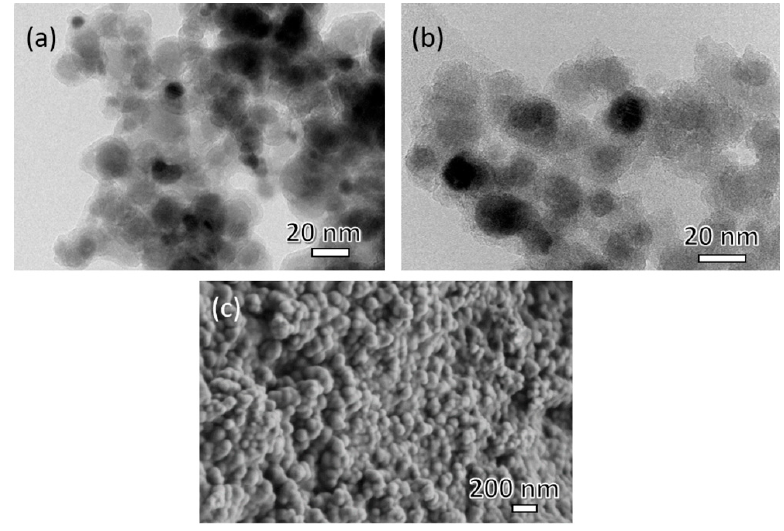
Figure 2. TEM image of MNPs@SiO 2 ( a ), TEM image of MNPs@SiO 2 @GOPTS-bPEI ( b ), and representative SEM image of MNPs@SiO 2 @GOPTS-bPEI ( c ). Note that darker spots in the TEM images correspond to the bare MNPs that overlap when deposited onto the copper grid.